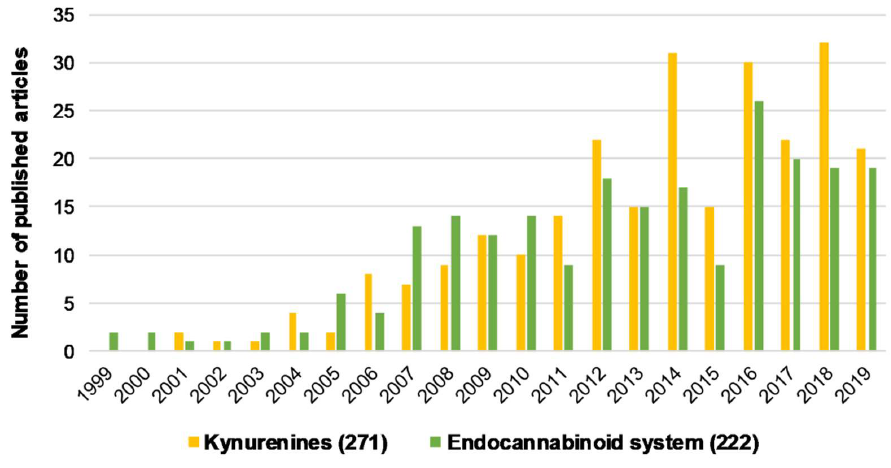
Figure 1. The number of articles published regarding kynurenines and the endocannabinoid system individually associated with schizophrenia from the last 20 years. Brackets indicate the total number of publications from the last 20 years. Data was obtained from PubMed using “kynurenines AND schizophrenia” and “endocannabinoid system AND schizophrenia” as keywords.